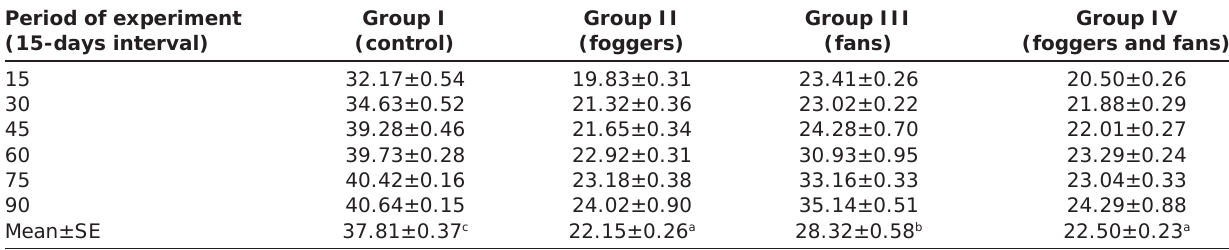
Table-7: Effect of microclimate alteration on respiratory rate (breaths/min) in Murrah buffaloes during summer. Period of experiment (15-days interval)